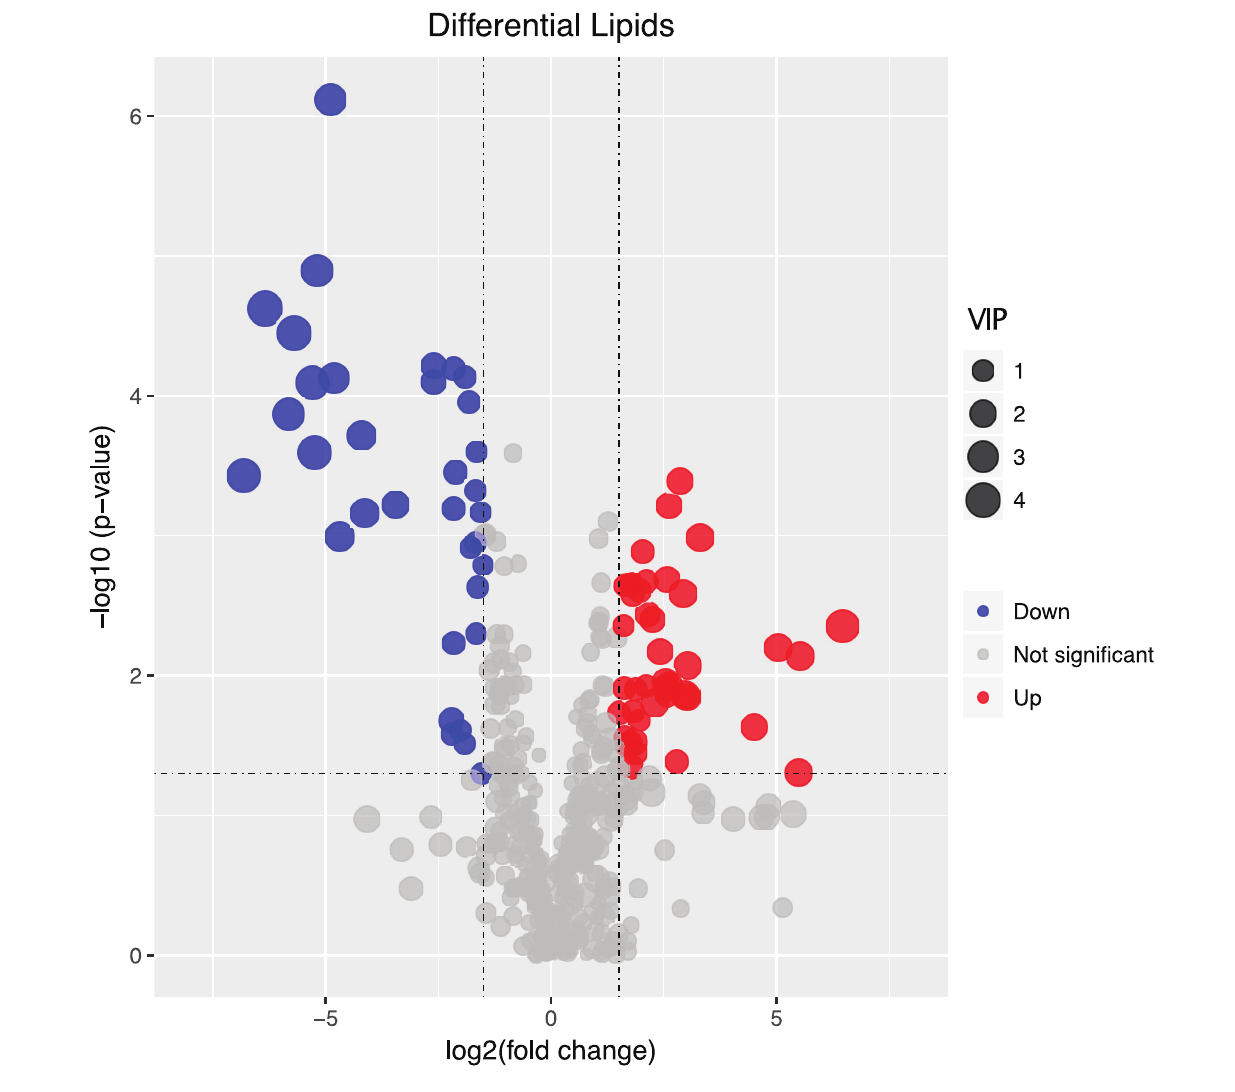
FIGURE 1 | Volcano plot displaying the differentially regulated lipid metabolites between long-term low (400 µ atm, LC) and high (1,000 µ atm, HC) CO 2 selected Phaeodactylum tricornutum cells. The dots represented in blue (down-regulated) and red (up-regulated) are differentially regulated lipid metabolites with > 2-fold change and a p -value of < 0.05. VIP value represents the importance projection value of the metabolite obtained from the PLS-DA